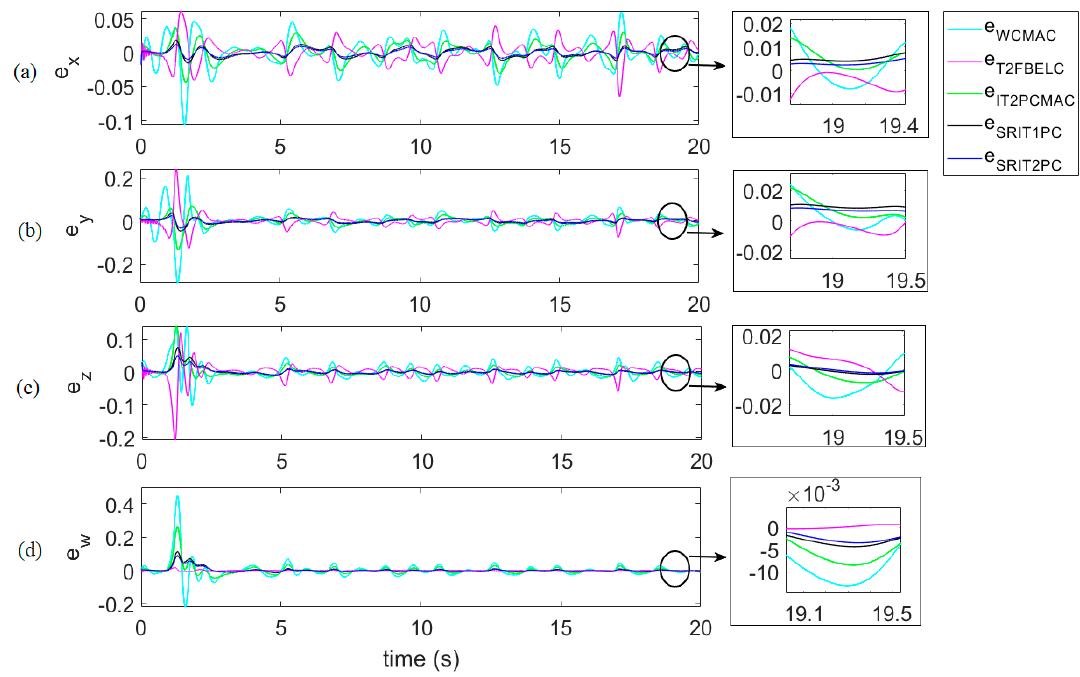
Figure 25. Tracking errors between the proposed SRIT2PC and other synchronization methods for Case 4: ( a ) e x , ( b ) e y , ( c ) e z , and ( d ) e w .